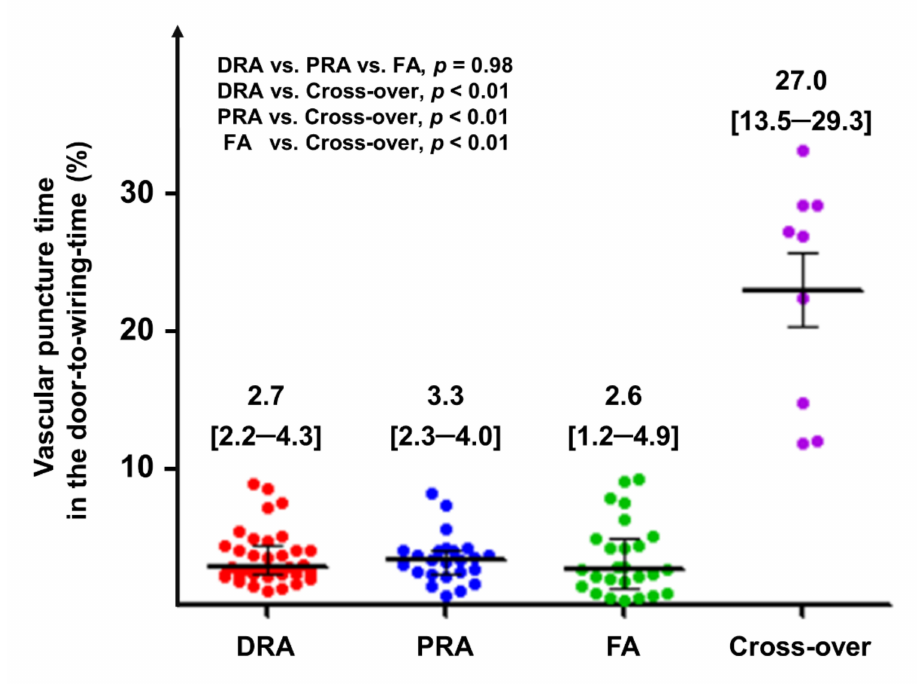
Figure 2. Percentage of the puncture time in the door-to-wiring time. Horizontal lines represent the median with the interquartile range. Abbreviations: DRA, distal radial access; FA, femoral access; PRA, proximal radial